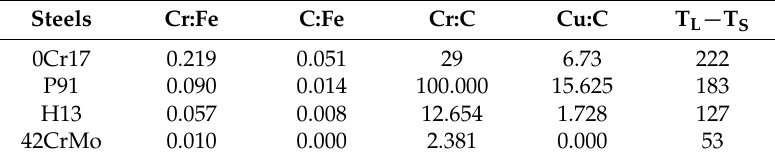
Table 3. Correlation of mushy zone to Cr:Fe, C:Fe, and Cr:C ratio. Steels